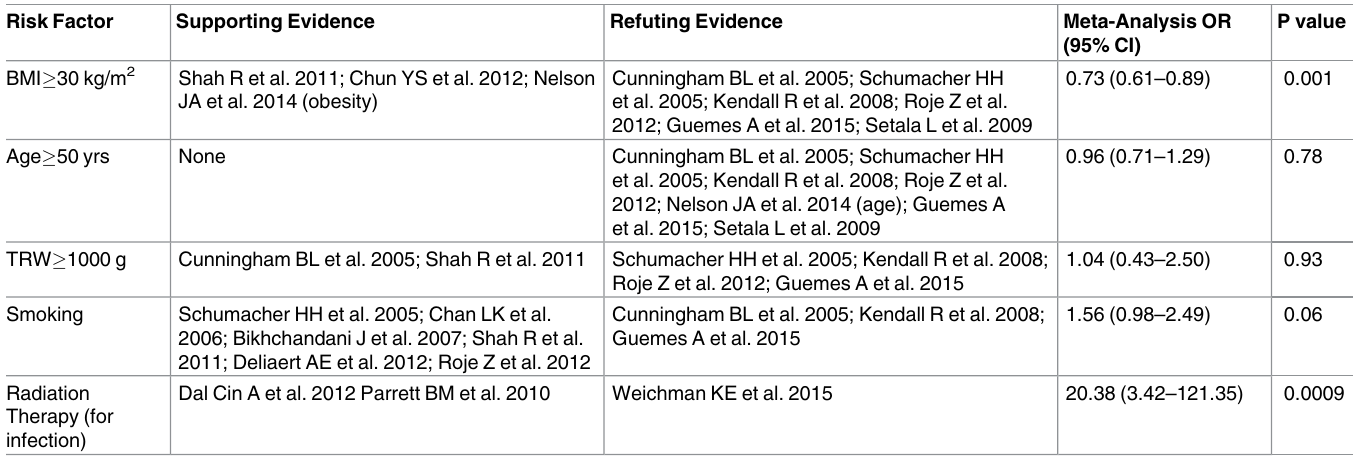
Table 1. Literature summaryof major risk factors for